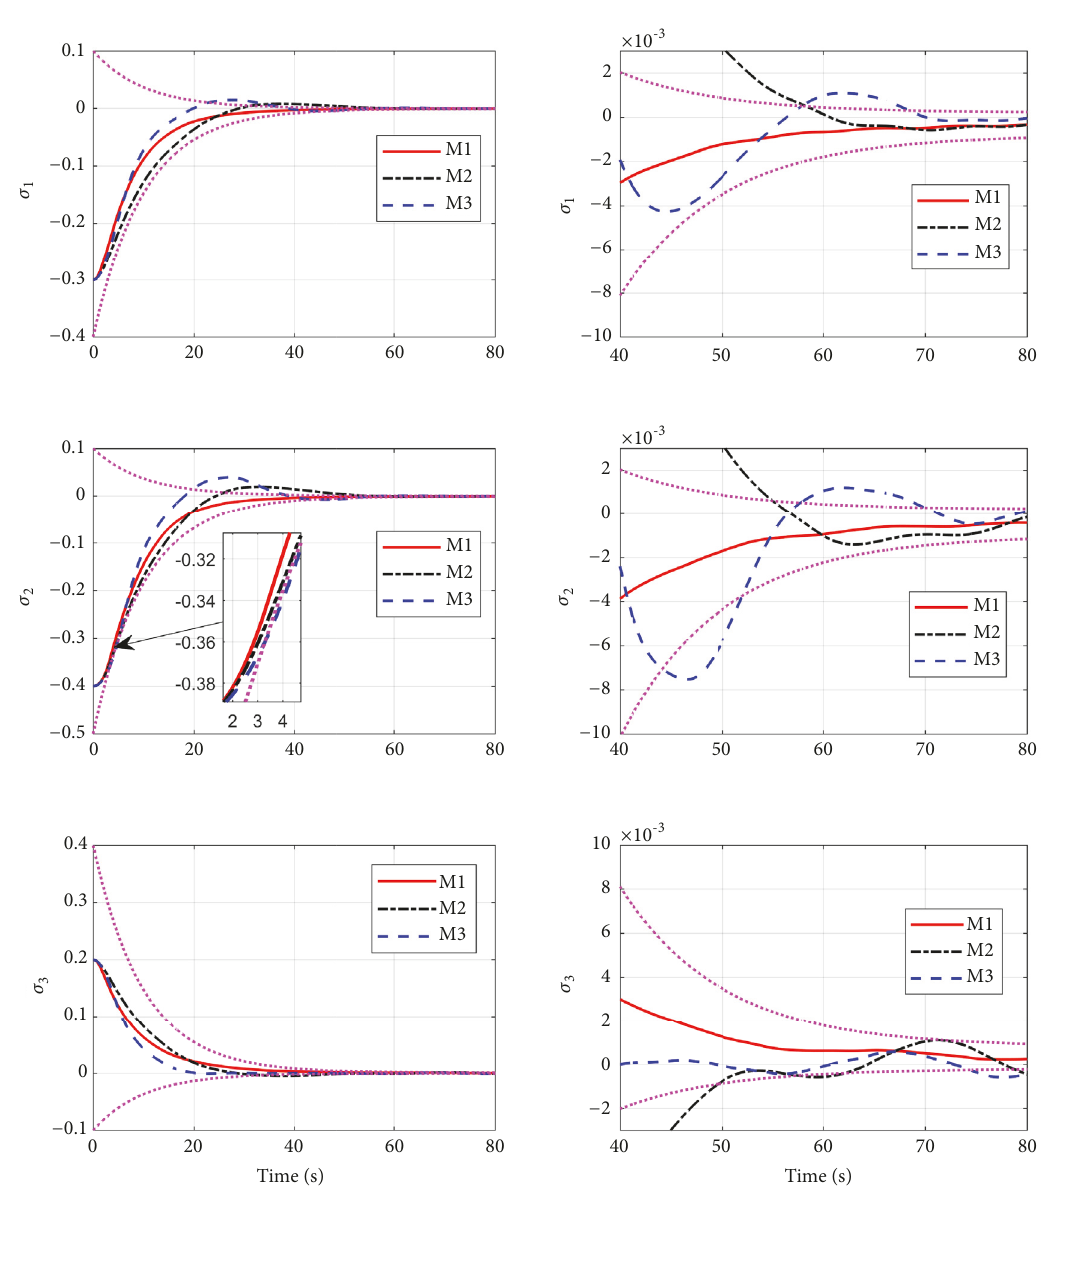
Figure 1: Attitude 𝜎 along with corresponding performance